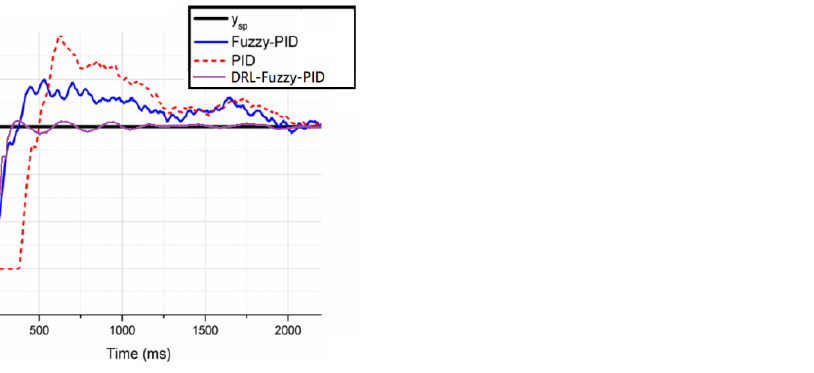
Figure 12. PID gain parameter tendency chart after modulation by DRL-Fuzzy-PID controller. ( a ) k p , ( b ) k d .